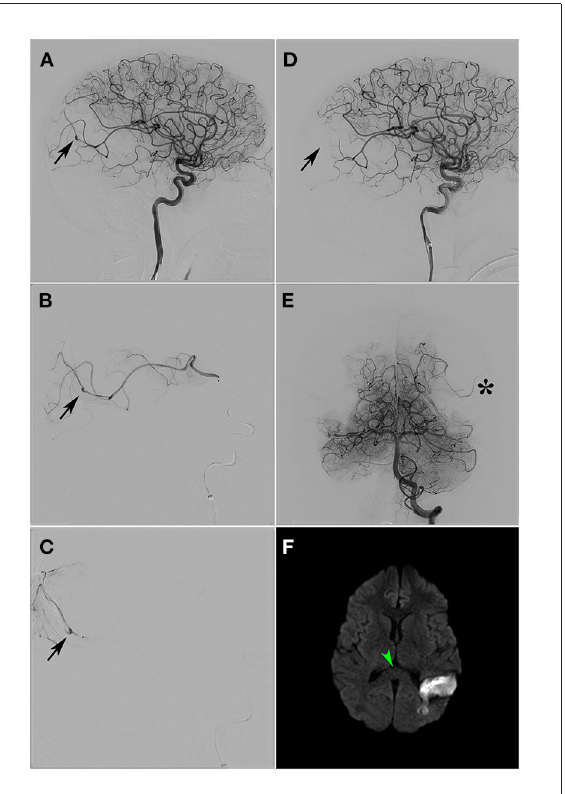
FIGURE2 (A) Cranial CT scan showing left temporo-occipital intraparenchymal haematoma. (B) Diffusion-weighted MR image showing increased signal (diffusion restriction) and